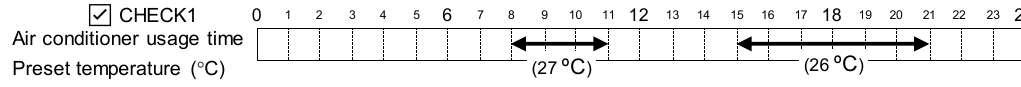
Table 2. The profile of investigated households.